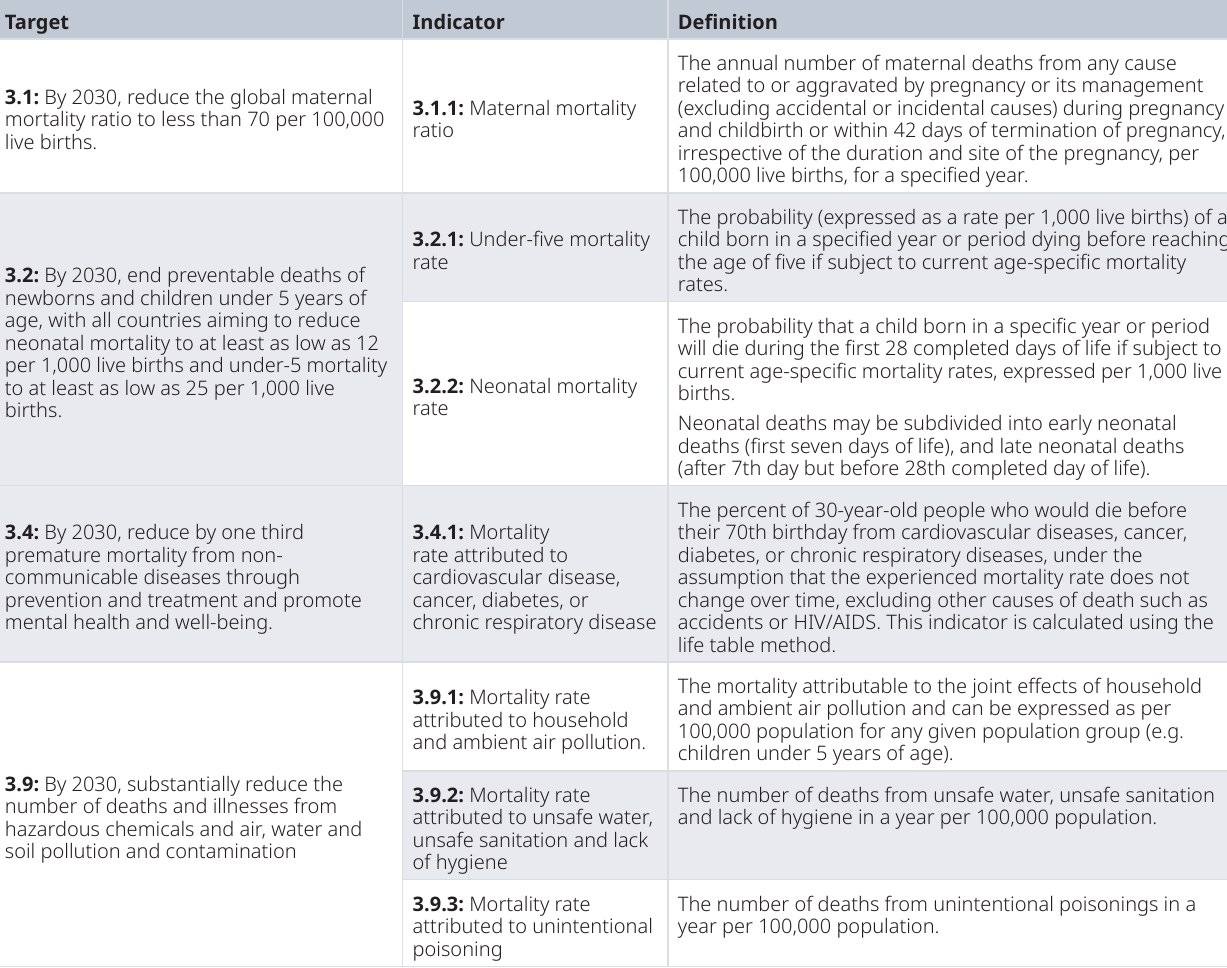
Table 1. Selected SDG indicators from SDG 3 that measure human mortality rates (UNSD, 2020a; UNSD, 2020b). Target